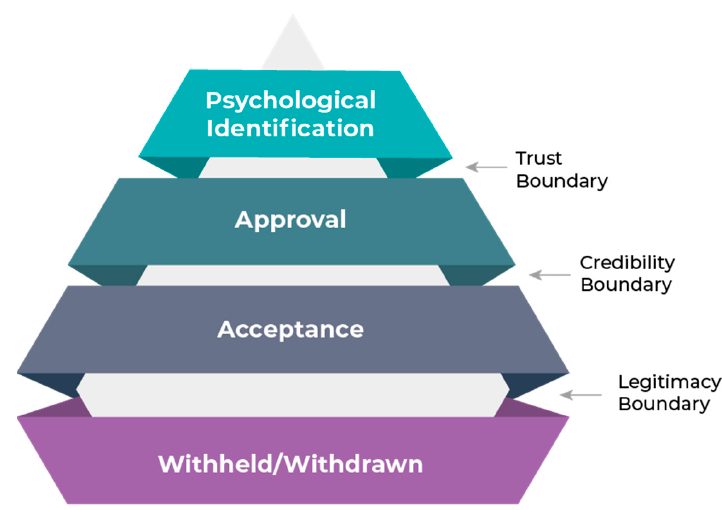
Figure 2. SLO pyramid model (modified after Thomson and Boutilier, [47]).